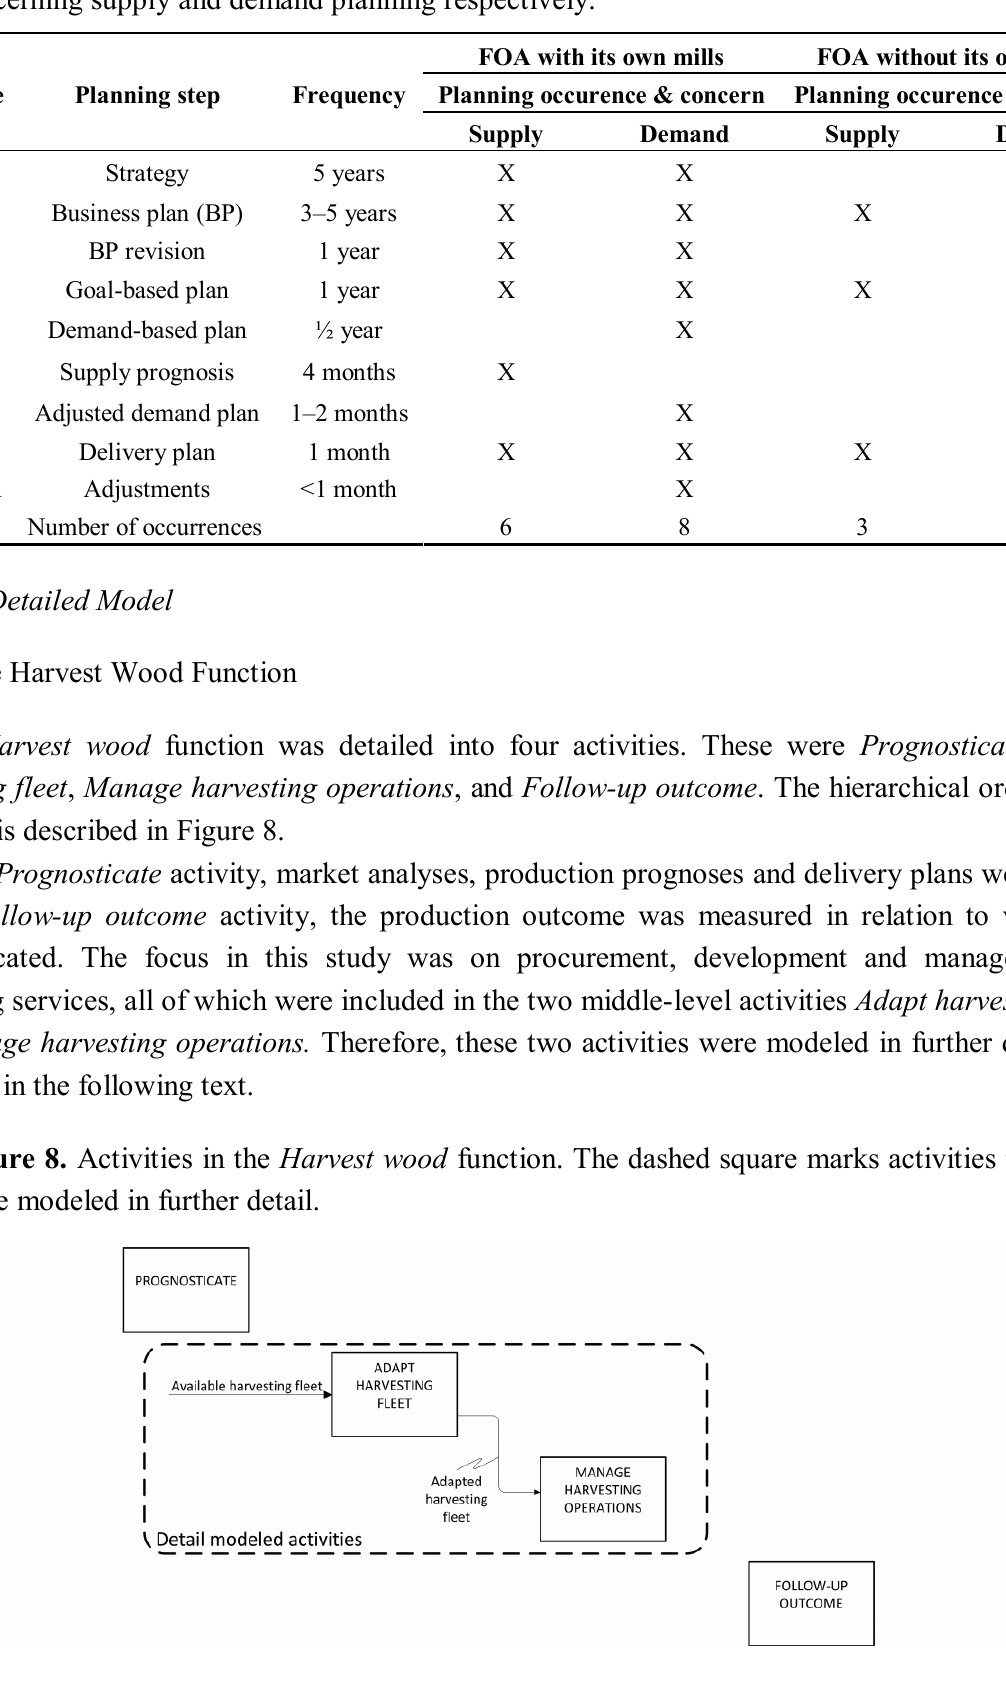
Table 3. Observed occurrences of planning steps (marked with X) in the two case FOAs, concerning supply and demand planning respectively.